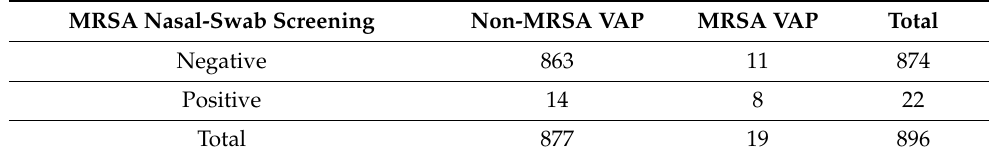
Table 2. MRSA nasal-swab